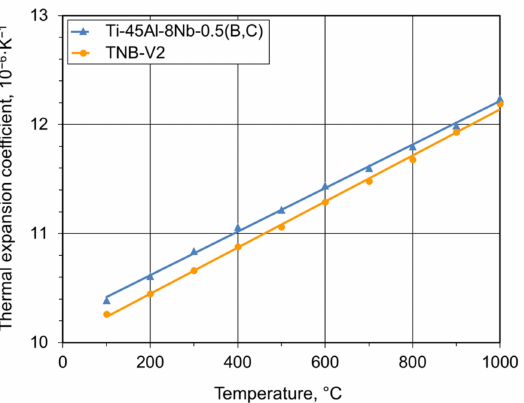
Figure 8. Linear thermal expansion coefficient of Ti-45Al-8Nb-0.5(B,C) and TNB-V2